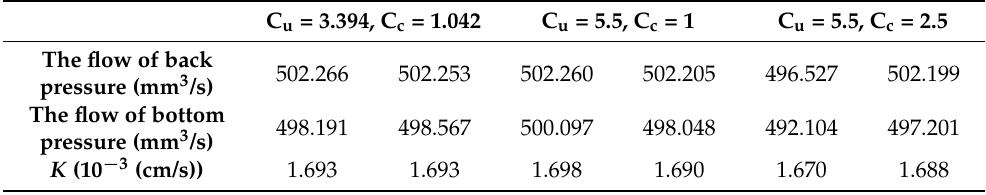
Figure 21. Seepage characteristics curves of tailing sand. Table 6. Flow records of specimens with different gradations under the action of